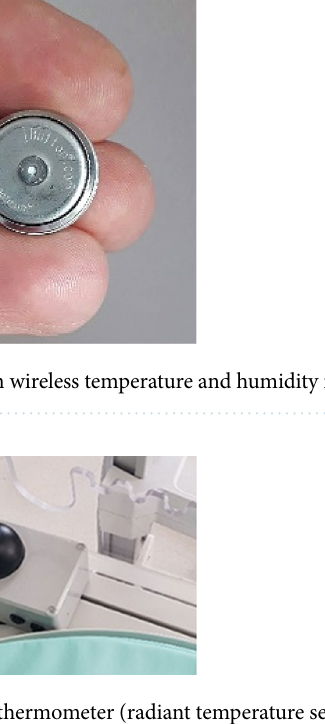
Figure 5. Globe thermometer (radiant temperature sensor) placed in the infant care